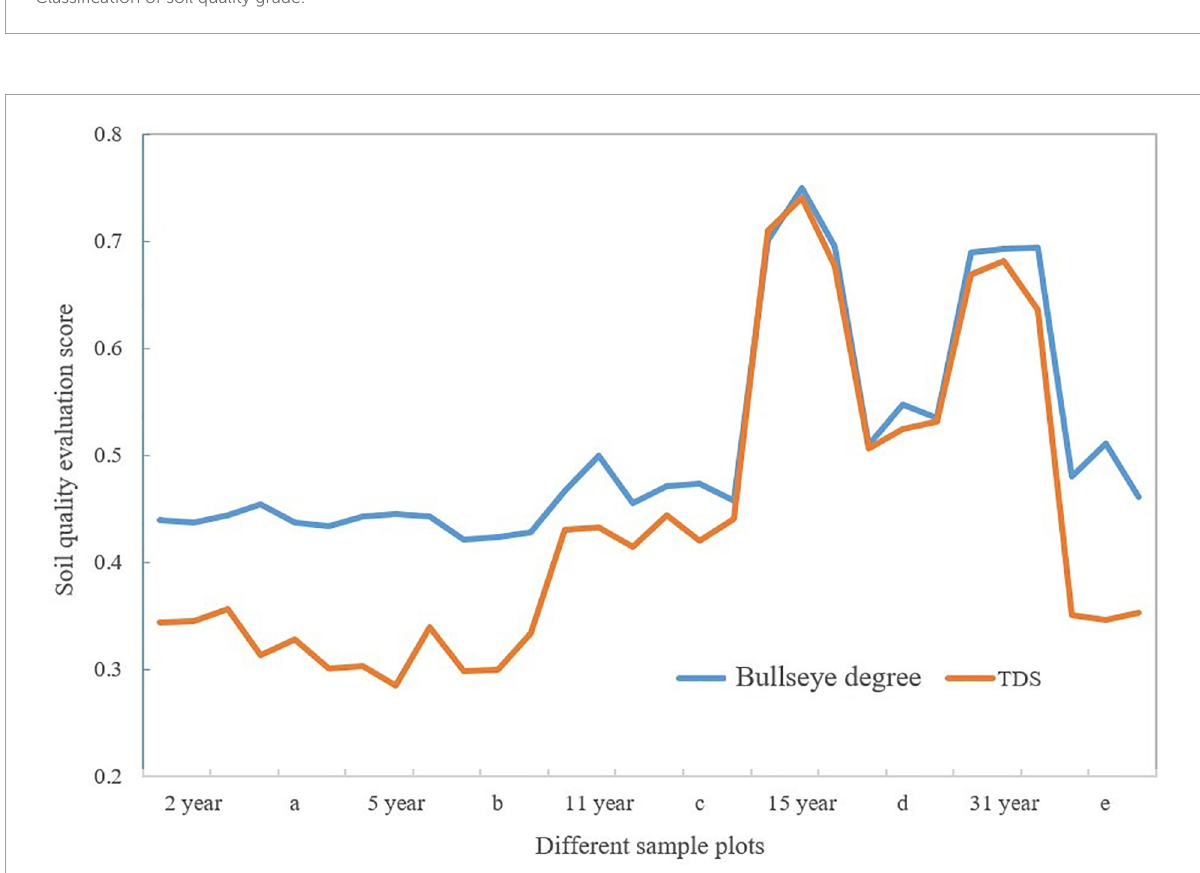
FIGURE9 Comparison of the different soil quality evaluation